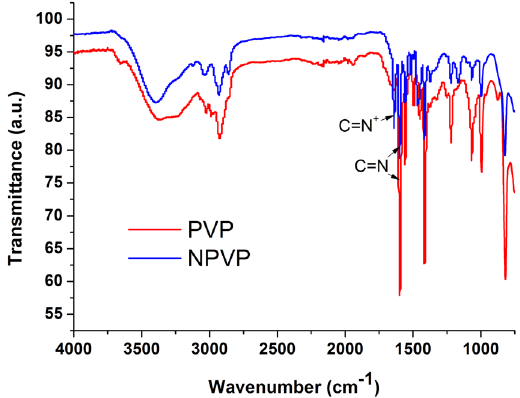
Figure 1. FTIR spectra of PVP and NPVP. The bands at 3400, 2900, 1467 and 1417 cm − 1 are assigned to hydroxyl peaks, a methyl or methylene peak, and a pyridine ring C = C peak, respectively. The success of the N-alkylation was verified by the C = N + stretching band at 1639 cm − 1